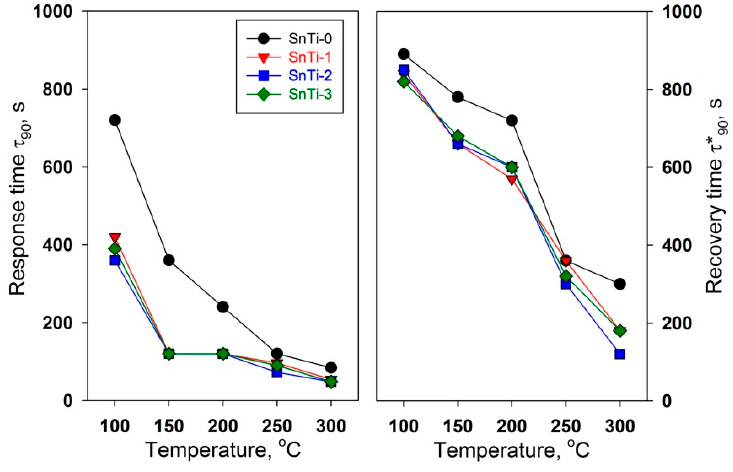
Figure 8. Temperature dependencies of response time τ 90 (left) and recovery time τ ∗ (right) during detection of 0.6 ppm HCHO in air in dark conditions.